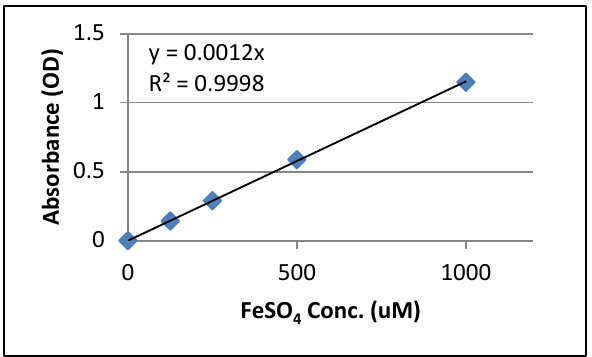
Figure 4. Standard curve for ferric reducing ability of plasma (FRAP) assay.